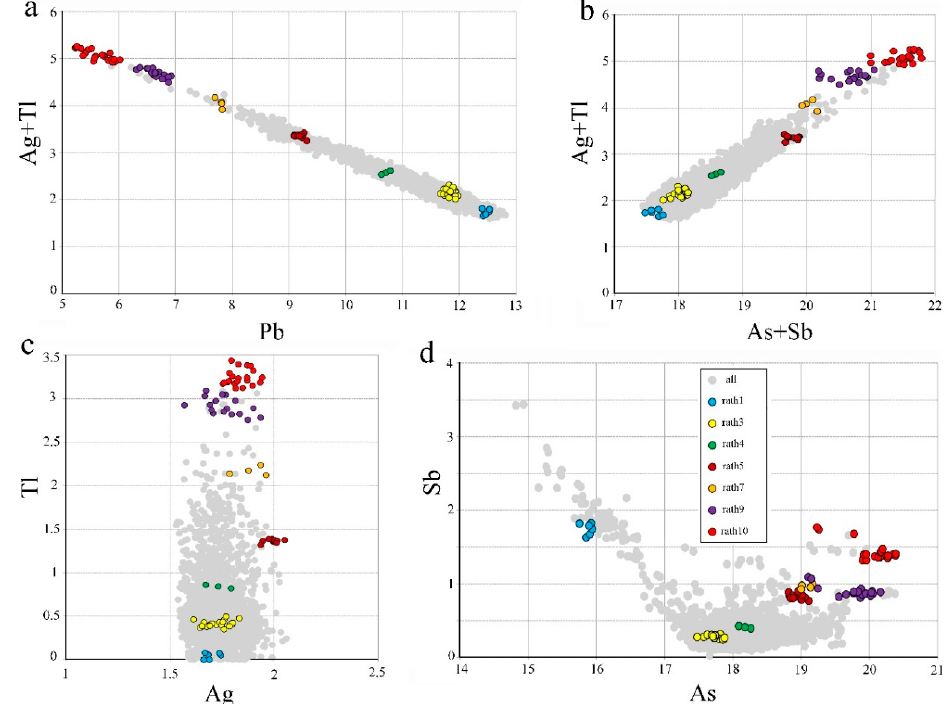
Figure 5. Binary plots ( a – d ) are based on apfu values of rathite and depict the correlations of (Ag + Tl) vs. Pb, (Ag + Tl) vs. (As + Sb), Tl vs. Ag, and Sb vs. As, respectively. Binary plots c and d clearly indicate the range of variations for Tl, Ag, and Sb.